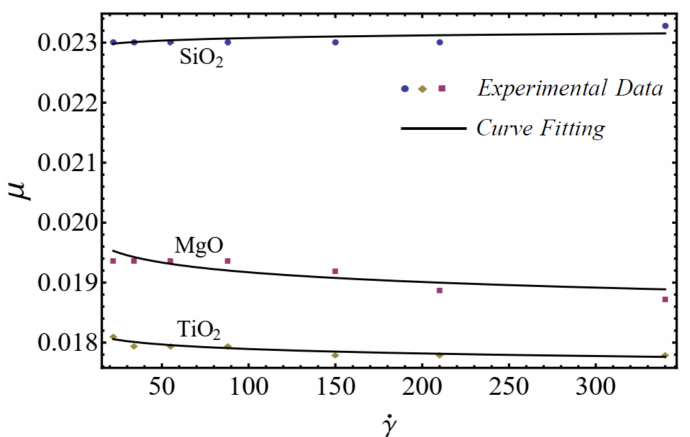
Figure 1. Experimental and mathematical rheological behavior of SiO 2 -EG, MgO-EG, and TiO 2 -EG nanofluids at 5% particle concentration.